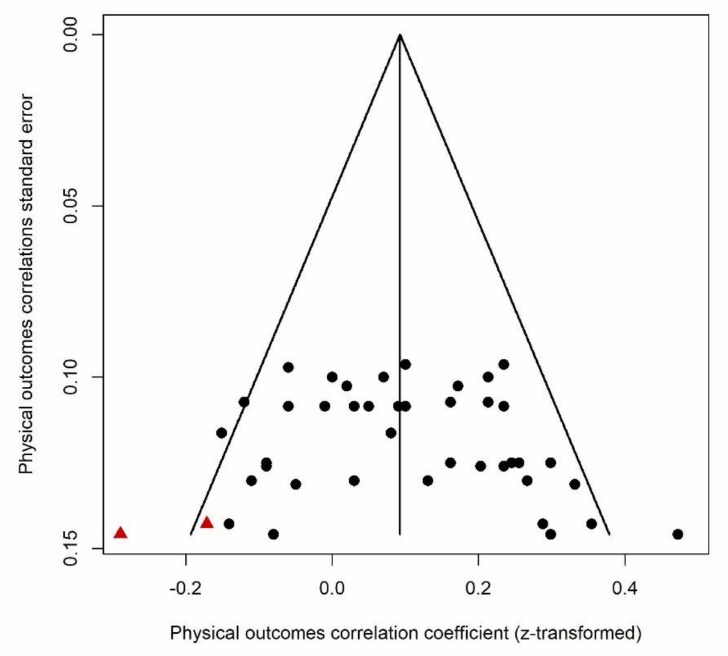
Figure 12. Physical outcomes funnel plot. Two negative effect sizes were added and are represented by red